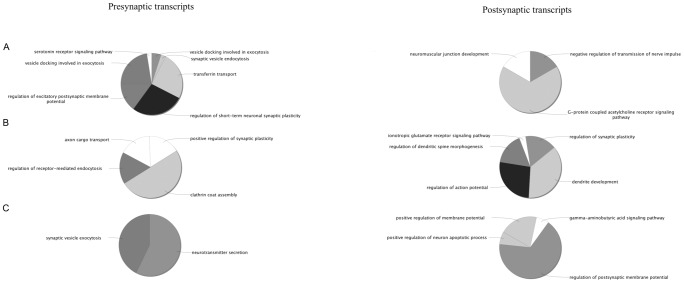
Gene ontology-enriched categories of synaptic mRNAs with least and most miRNA predicted interactions.GO-enriched categories determined by ClueGo in (A) transcripts with zero or one predicted miRNA site (B) transcripts with over eight different miRNA sites and (C) common to both transcript groups with least and most miRNA sites. A two-sided hypergeometric test yielded the enrichment for GO terms. Benjamini-Hochberg correction for multiple testing controlled the P-values.